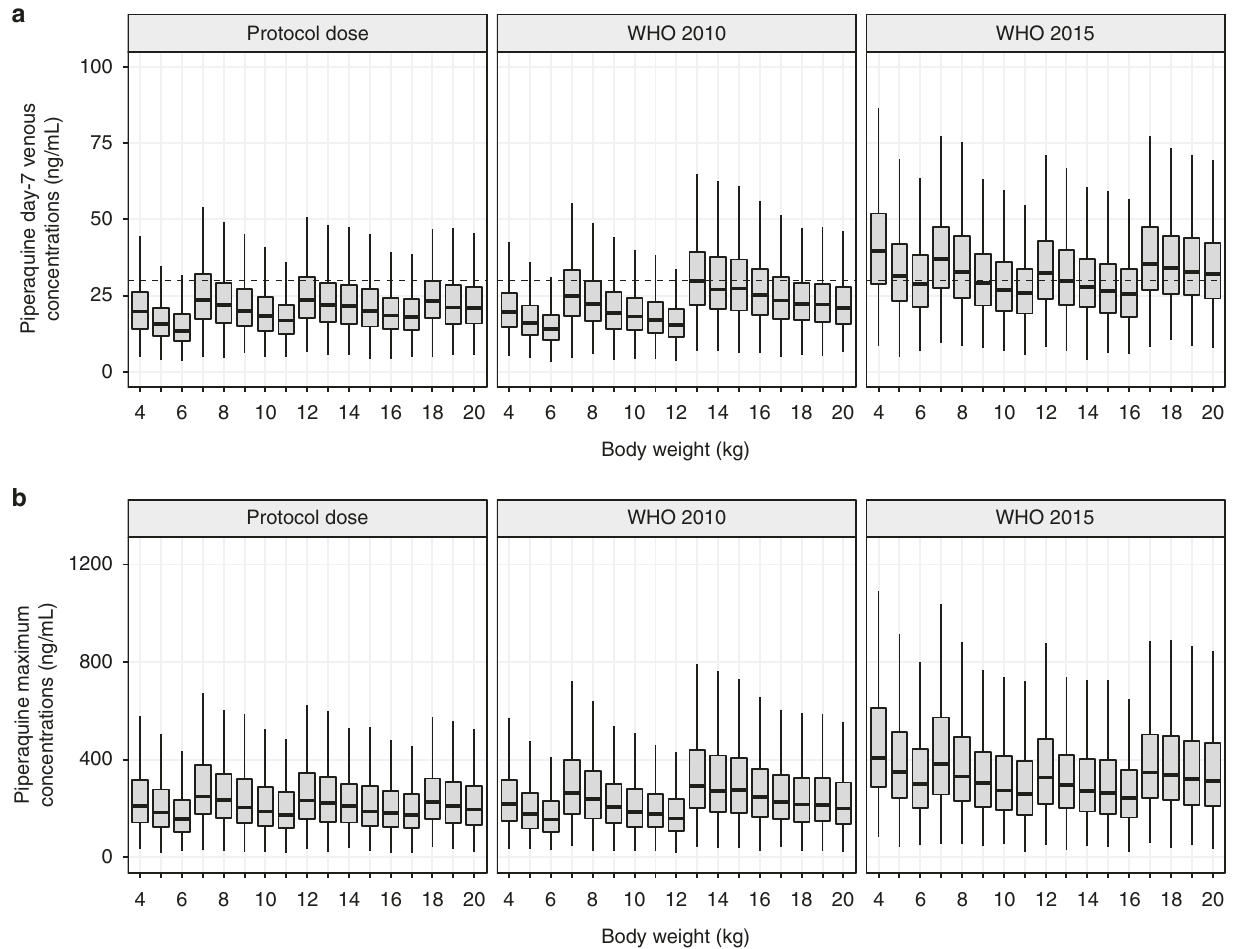
Fig. 2 Simulated venous piperaquine concentrations. a Day-7 piperaquine concentrations and b peak piperaquine concentrations after different dosing regimens, strati fi ed by body weight. The box-whisker plots represent the median with inter-quartile range and the 95% prediction interval of 1000 simulated individuals per body weight. The horizontal dashed line represents the previously de fi ned 30 ng mL -1 cut-off concentration at day